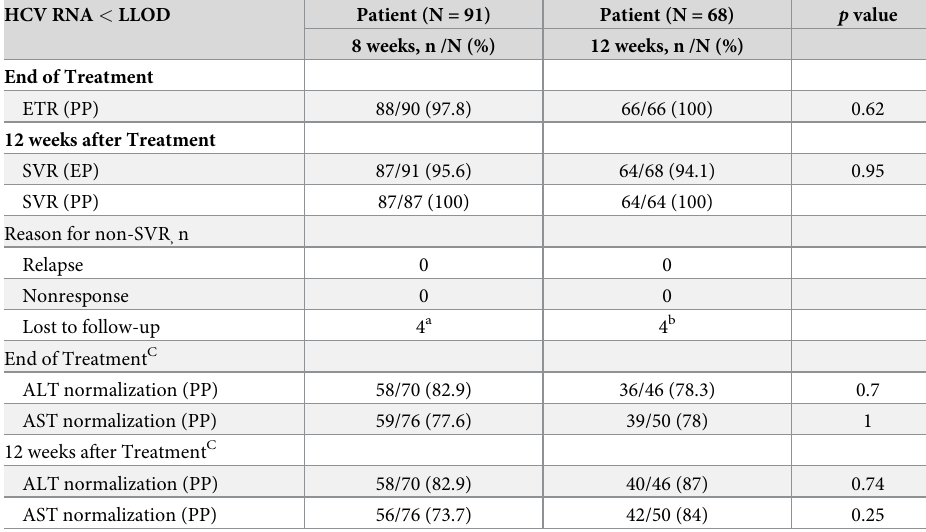
Table 2. Virological and biochemical